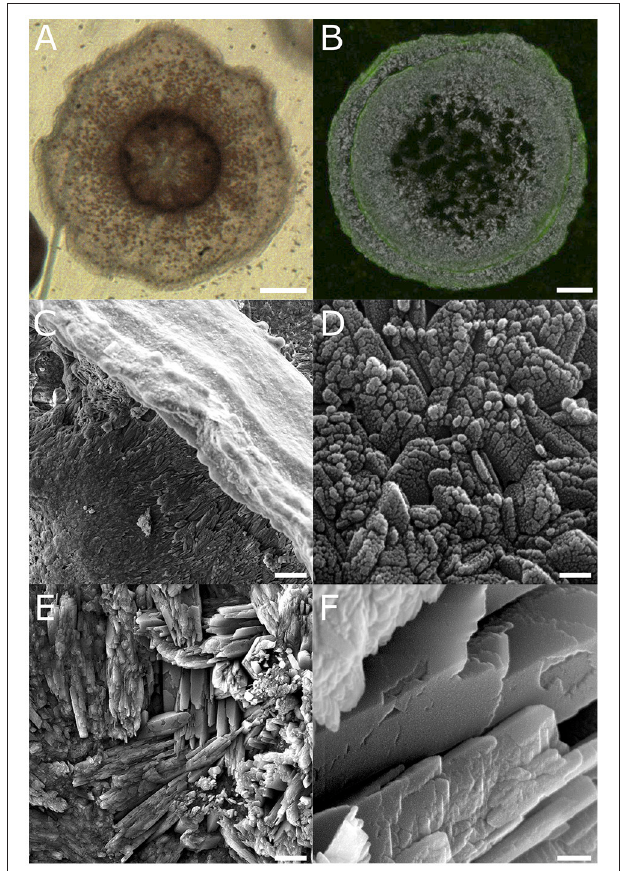
FIGURE 1 | Two distinct phases observed in the skeleton of P. damicornis micropropagates. (A) Micropropagate from a P. damicornis 24h following settlement. Polyp mouth is seen in the center surrounded by septa. Brown dots are individual zooxanthellae cells. Scale − 250 µ m. (B) Skeleton of a P. damicornis micropropagate 5 days after settlement, following calcein staining and bleach treatment. Visualization by a combination of polarized light microscopy (gray scale) and epifluorescence (green). Green fluorescence, denoting calcein incorporation, was largely restricted to protruding structures (such as the calyx wall), with little or no incorporation observed within the basal plate area. Scale − 100 µ m. (C–F) High resolution SEM showing the skeleton of a micropropagate 6 weeks from settlement. (C) Low magnification view of the calyx wall, corresponding to the area labeled with calcein in (B) shows a characteristically smooth surface. (D) High magnification of the top of the calyx wall shown in (C) reveals nm-scale granulation. (E) Large crystals of fibrous aragonite growing at various orientations compose the calyx basal plate. (F) High magnification of the fibrous aragonite in (D) reveals the smooth surface of individual fibers, suggesting a different calcification process from the clayx wall and similar protruding structures. Scale bars: (C,E) − 10 µ m, (D,F) − 0.1 µ